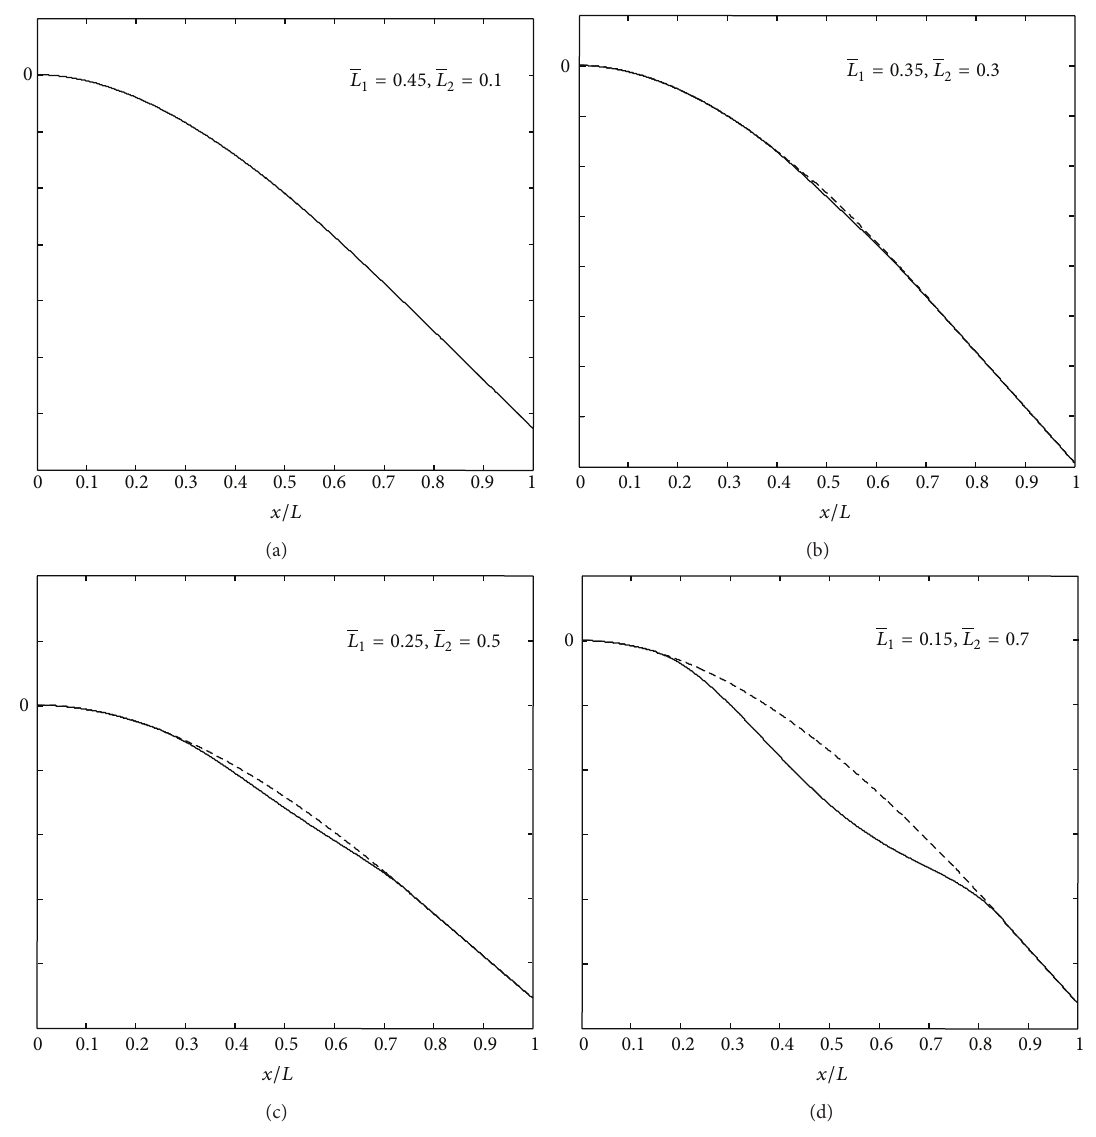
Figure 6: Mode shapes of the delaminated beam with ( 𝐻 2 = 0.1